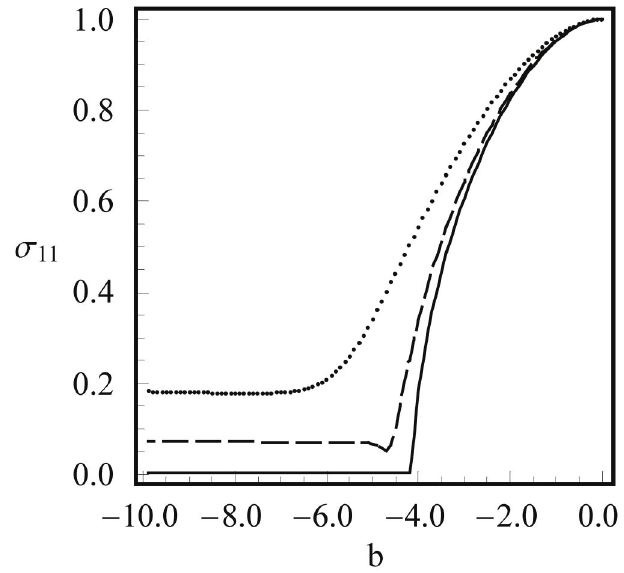
FIG. 6. Gaussian approximation with physically regularized (cid:3) 0 wake, Eq. (5.1). (cid:22) vs b < 0 for a (cid:6) 0 : 1 (dotted line), a (cid:6) 0 : 05 11 (dashed line), a (cid:6) 0 : 01 (solid line), with T (cid:6) 200 , (cid:15) (cid:6) 150 and N s